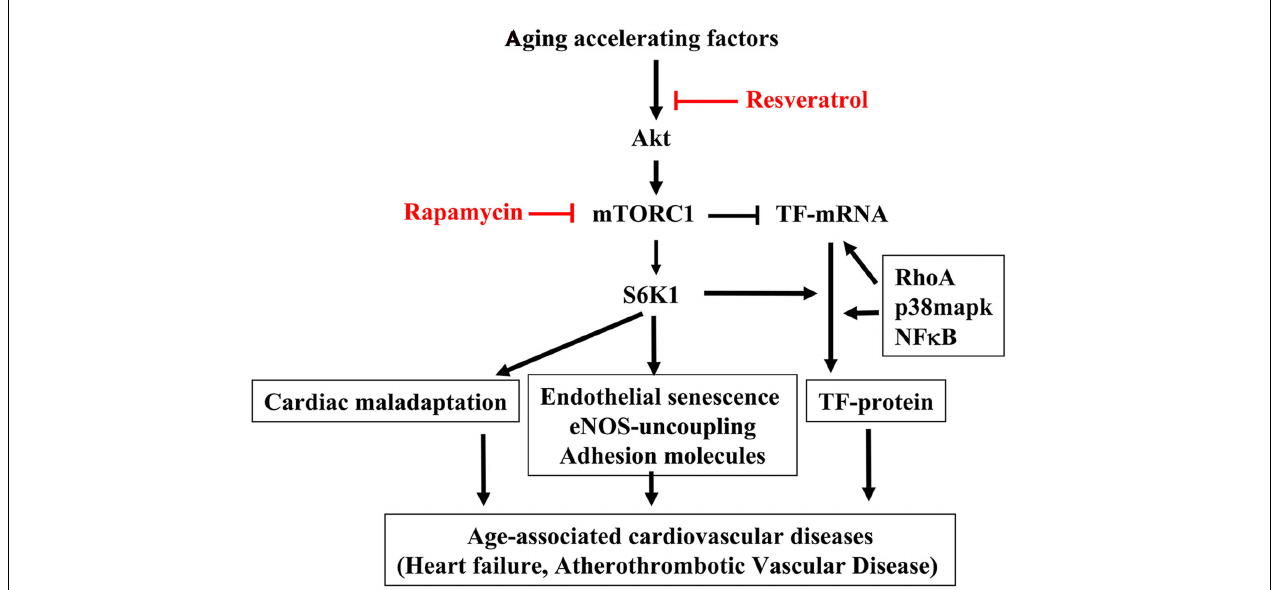
FIGURE 2 | mTORC1–S6K1 signaling in cardiovascular aging. Aging accelerating factors cause persistent activation of the Akt–mTORC1–S6K1 signaling.The hyperactive S6K1 has pleiotropic effects in cardiovascular system. In heart, it causes